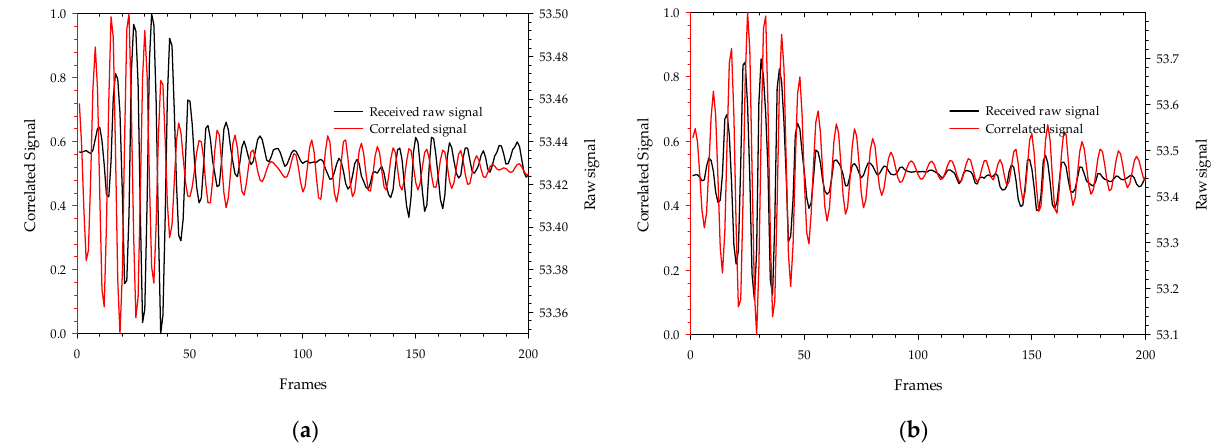
Figure 8. The received pulse signal level with and without correlation obtain from 6.8 GHz transmission: ( a ) Without sleeping body; ( b ) With sleeping body.